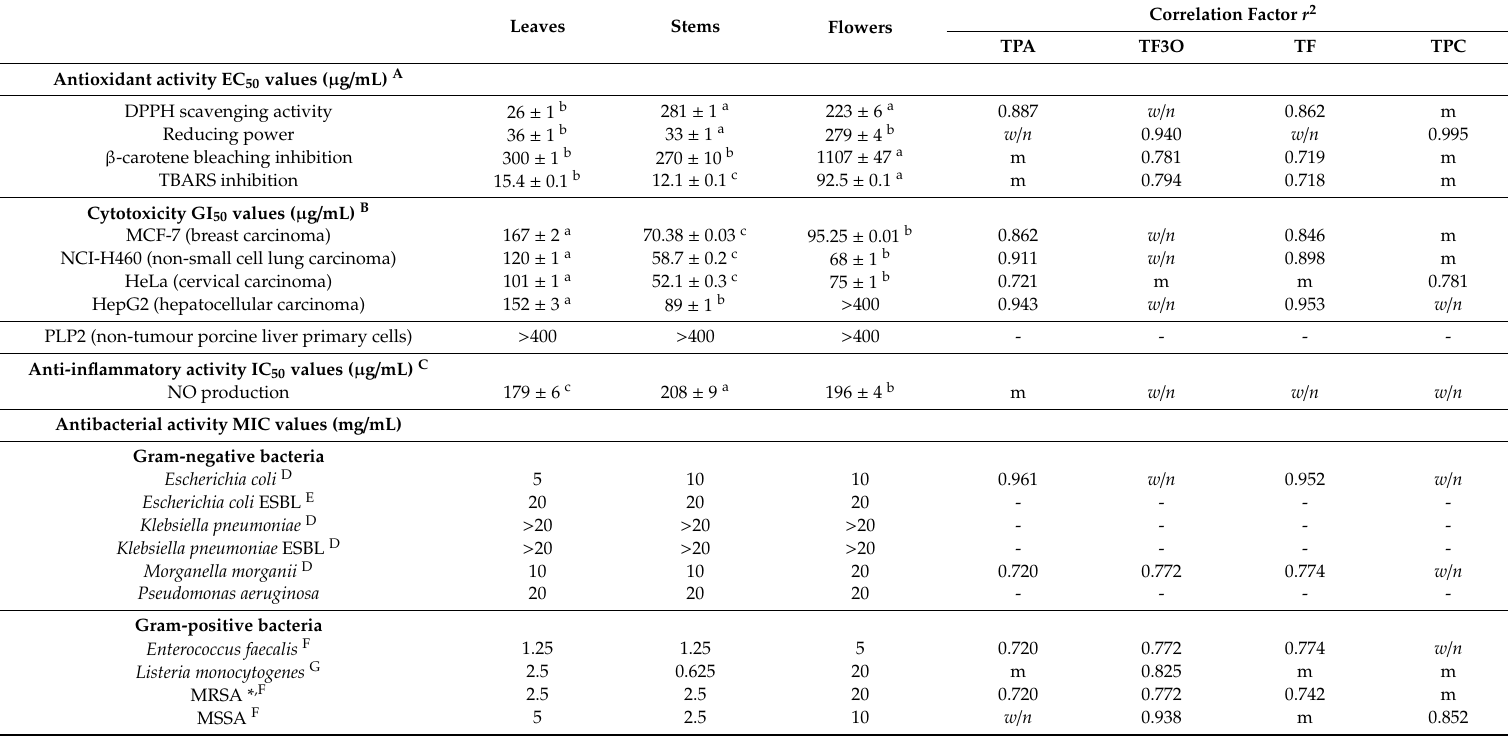
Table 3. Antioxidant, cytotoxic, anti-inflammatory, and antibacterial activities of hydroethanolic extracts of C. macrocarpa leaves, stems, and flowers, and their correlation with the families of the phenolic compounds identified (mean ±